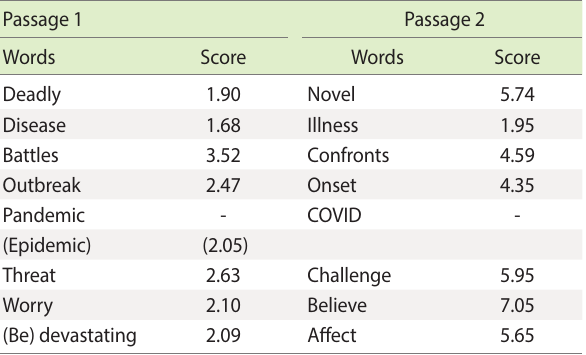
Table 1. Words used in the 2 passages and their mean valence scores in the parenthesis (1 [unhappy]-9 [happy]) Passage